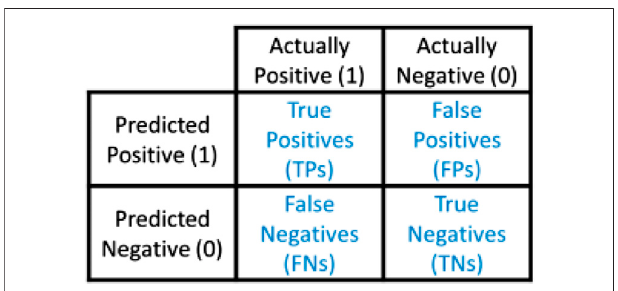
FIGURE 3 | Confusion matrix (Draelos,